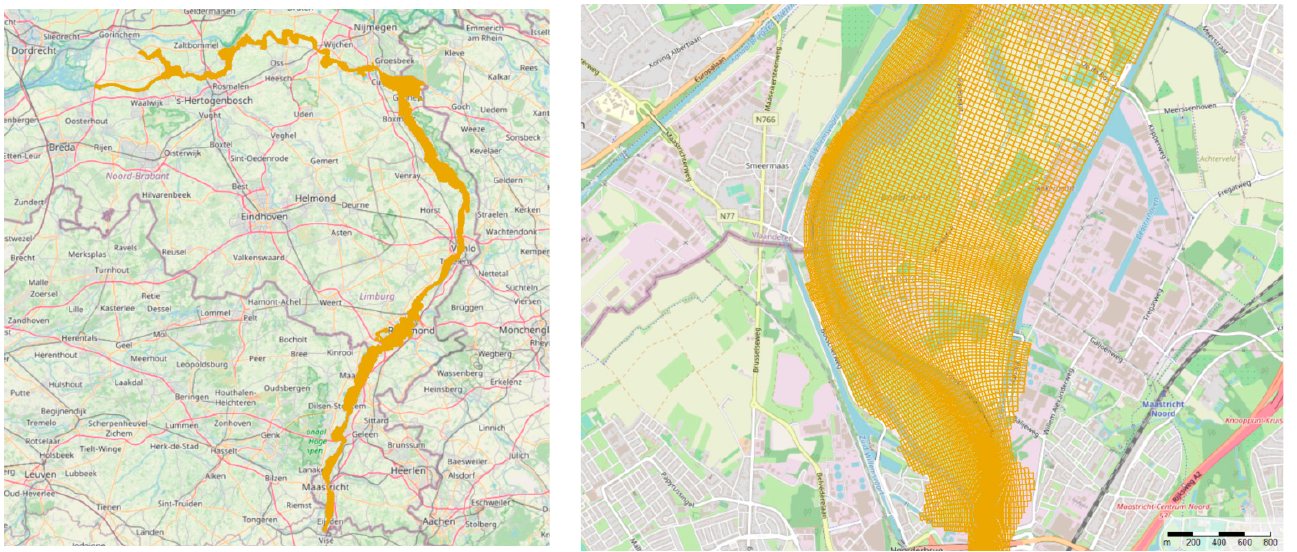
Figure 8 . Overall grid for the river Meuse model ( left panel ) and zoomed in for the Grensmaas ( right panel ).